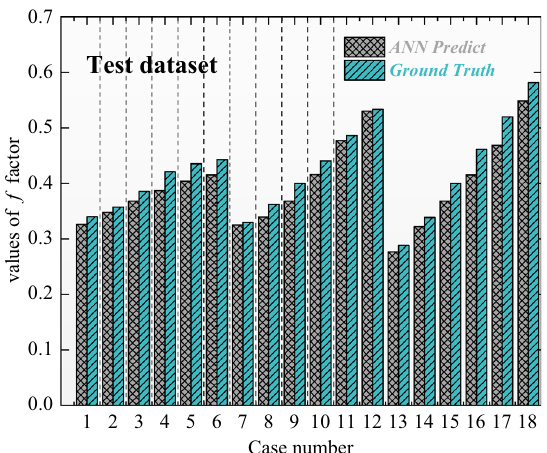
Figure 13 Comparison of predicted and actual values of the f factor